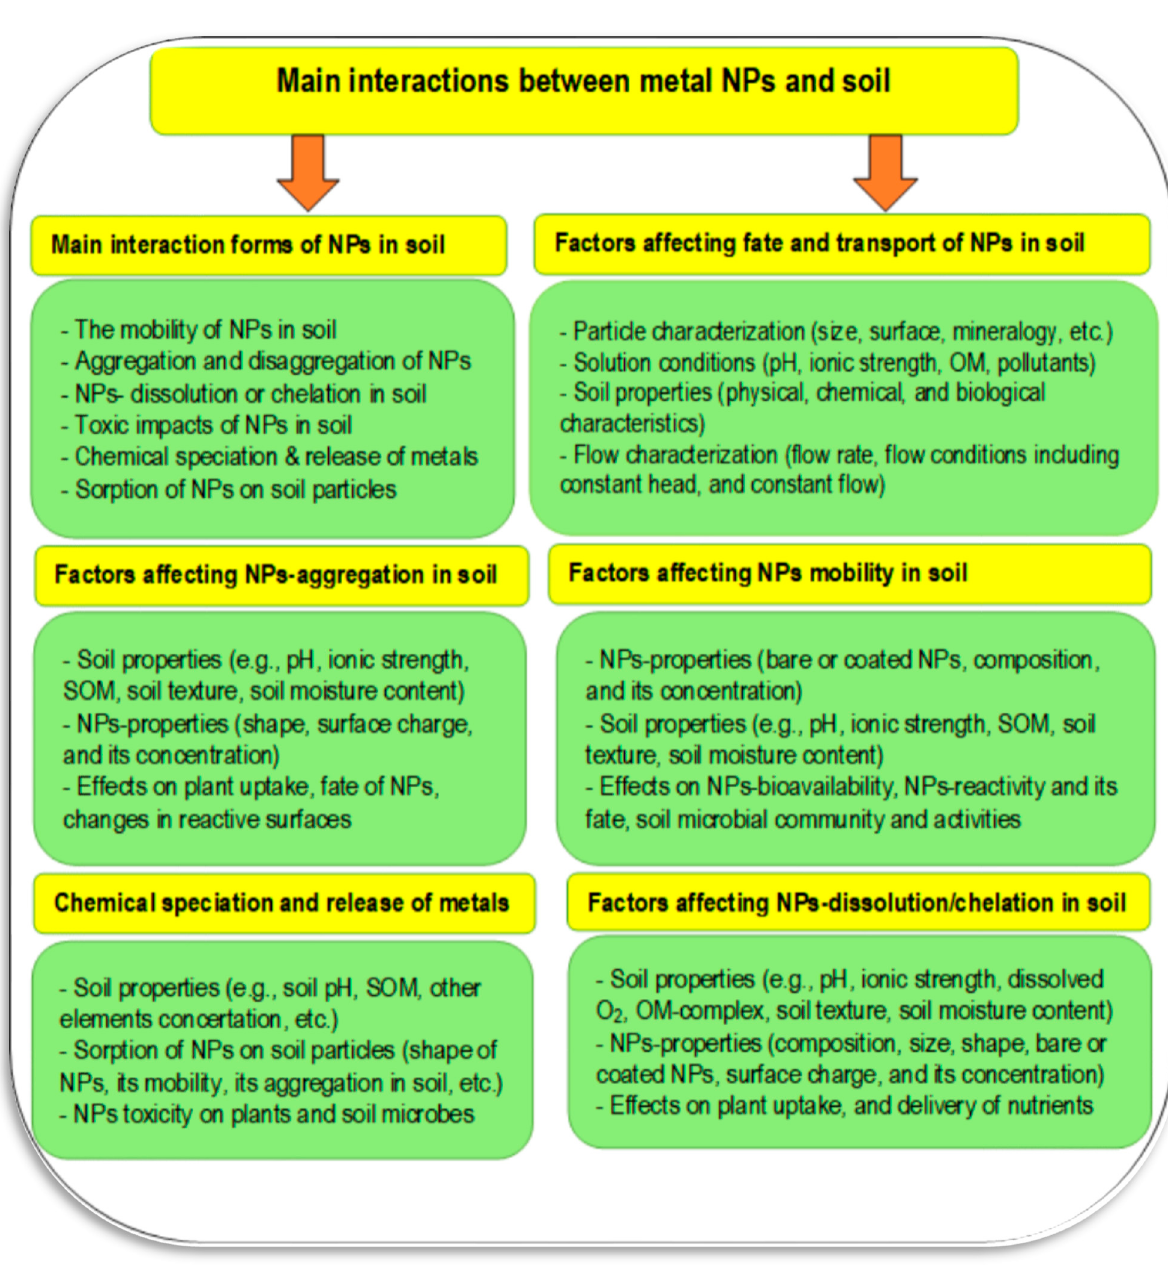
Figure 17. The main fate and interactions of nanoparticles in soil including various components of the soil system (Sources: [118,120]).